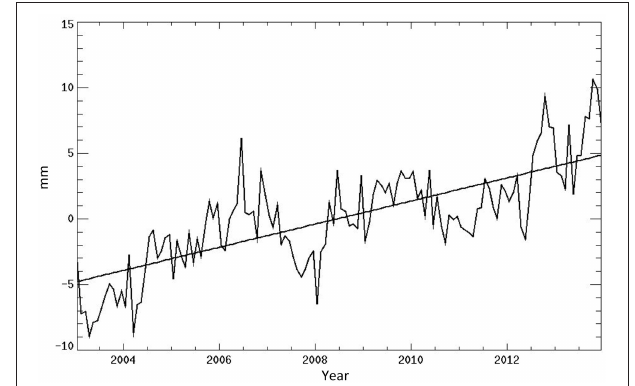
FIGURE 4 | The steric sea level obtained from the altimeter and GRACE data. The straight line shows a linear fit of the